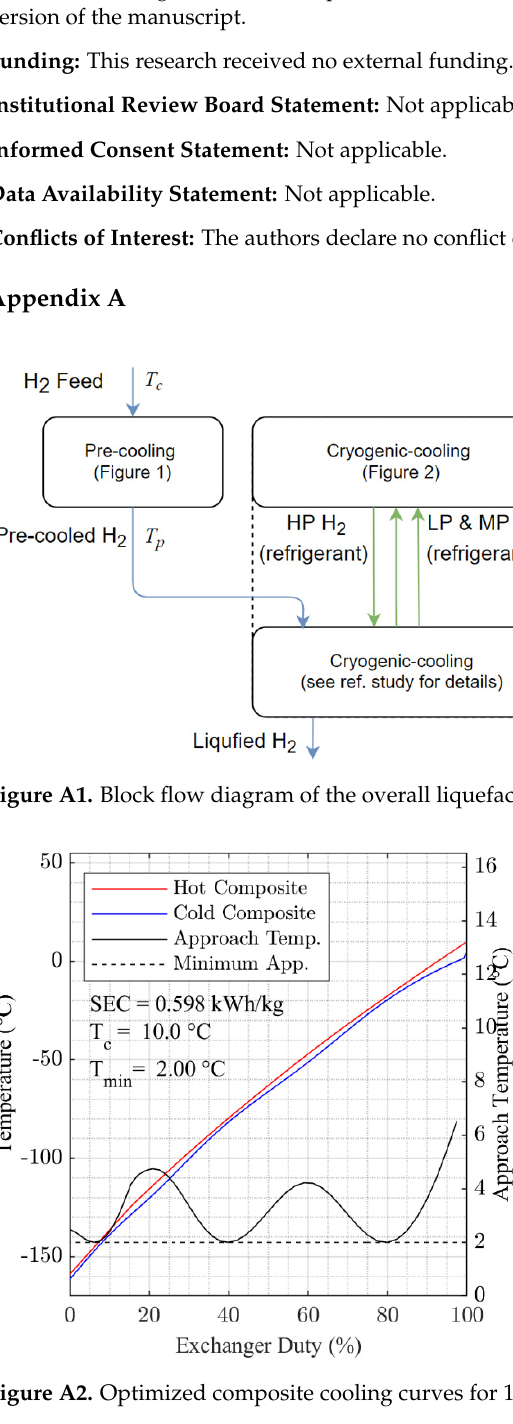
Figure A2. Optimized composite cooling curves for 10°C cooling temperature.